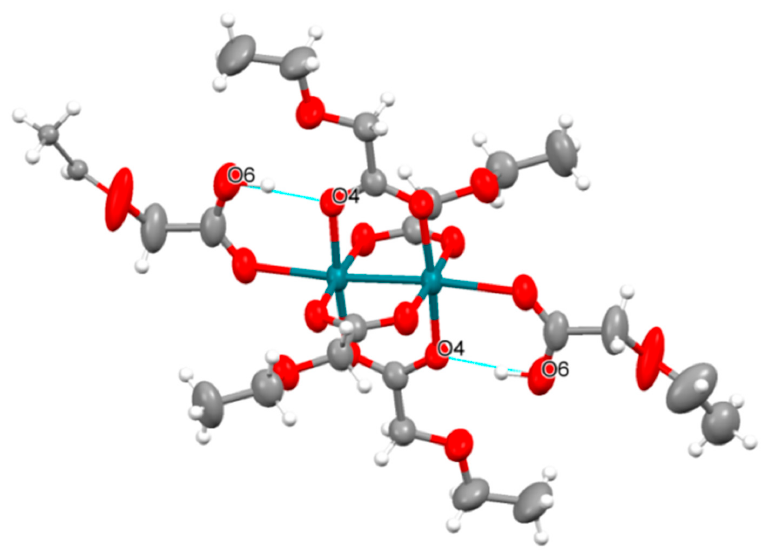
Figure 2. Representation of the paddlewheel unit of 2a (50% probability ellipsoids) showing the intramolecular hydrogen bonds (blue line) present in this compound. Rhodium: green; oxygen: red; carbon: grey; hydrogen: white.